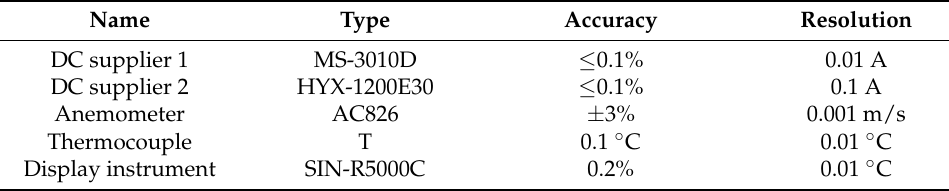
Figure 3. The experimental figure. ( a ) The physical structure of the experiment, ( b ) the schematic structure of the test, ( c ) physical picture of thermoelectric refrigeration module. Table 3. Measuring devices and their characteristics.